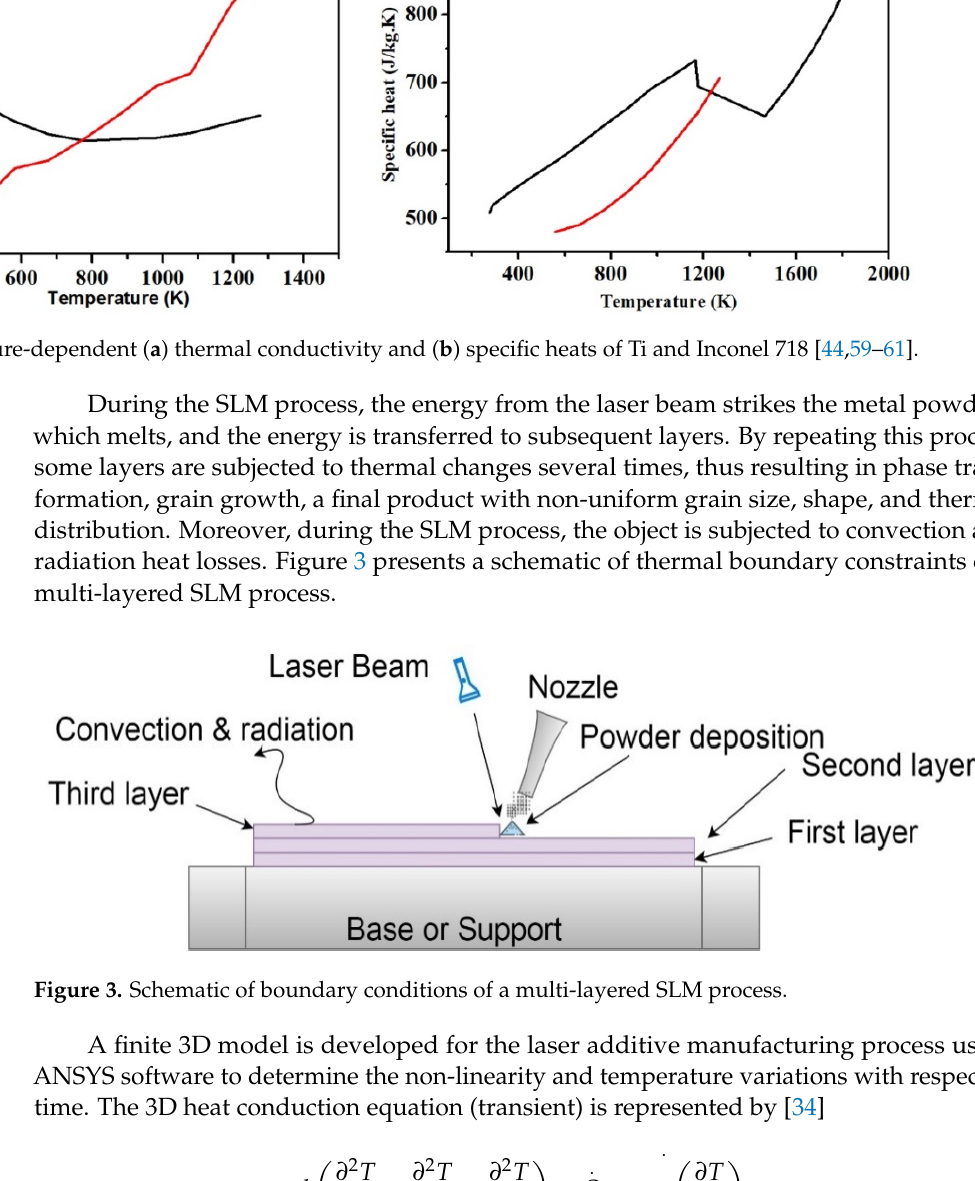
Figure 3. Schematic of boundary conditions of a multi-layered SLM process.